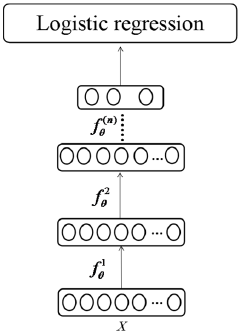
Figure 4. Architecture of SDAE.